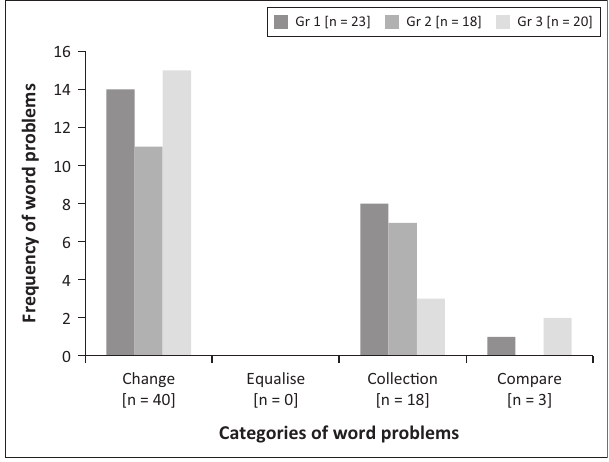
FIGURE 14: Distribution of word problems across four main categories by